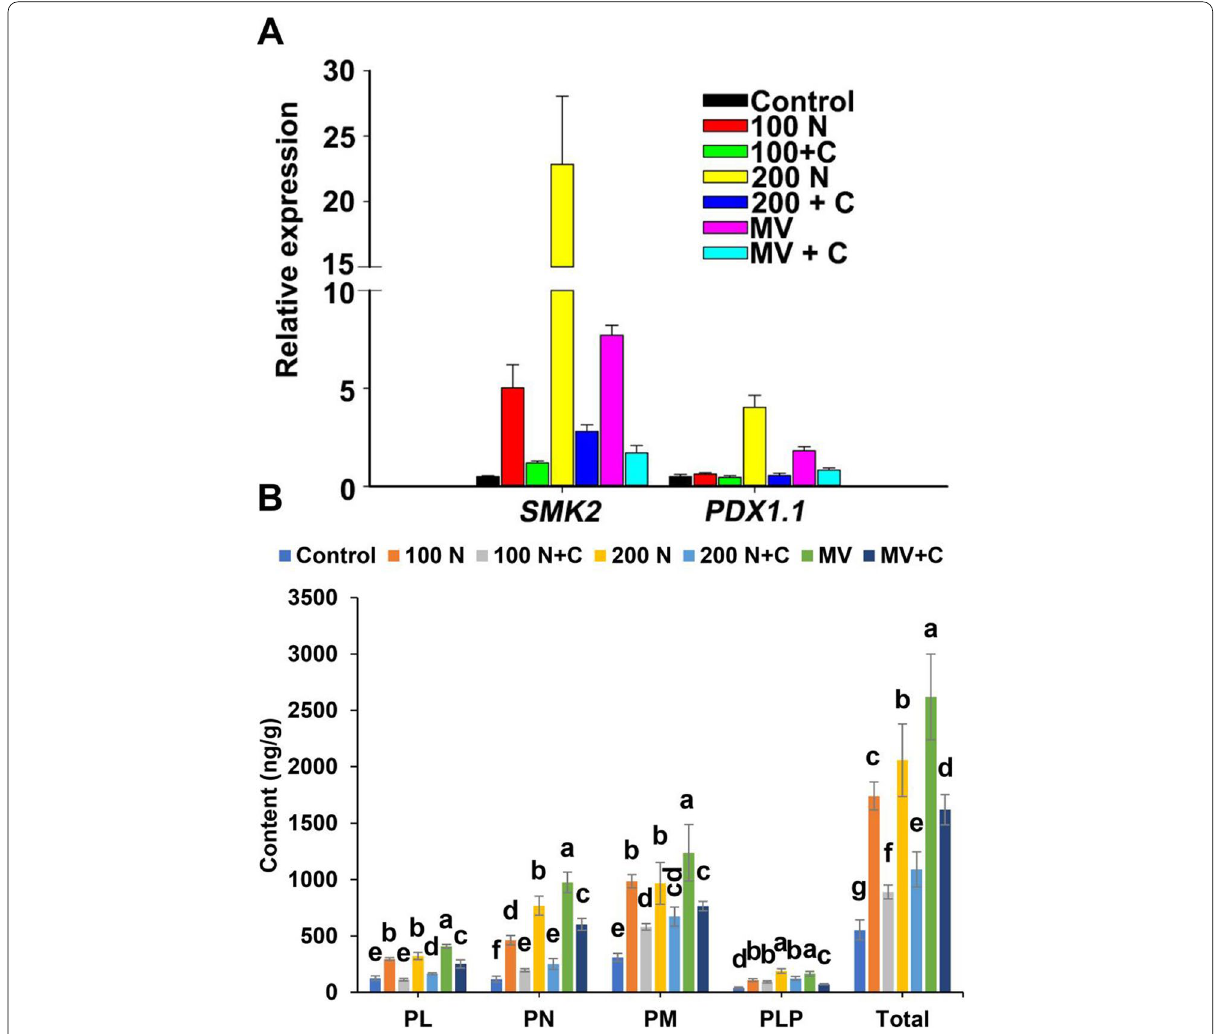
Fig. 2 Salt and oxidative stress induced VB 6 accumulation in maize roots. A qRT–PCR analysis of SMK2 and PDX1.1 expression in maize roots of 6-d-old seedlings subjected to H CAT for 24 h. B HPLC detection of the contents of PL, PN, PM, and PLP after different treatments for 24 h. The different + letters represent significant differences ( P < 0.05, based on one-way